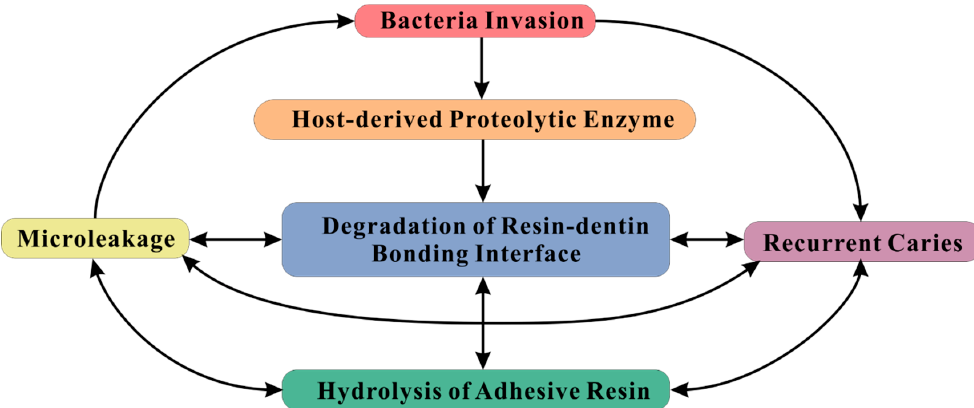
Figure 1. Factors involved in failure of resin-dentin bonding. The arrows represent aggravation effects of the respective factors.